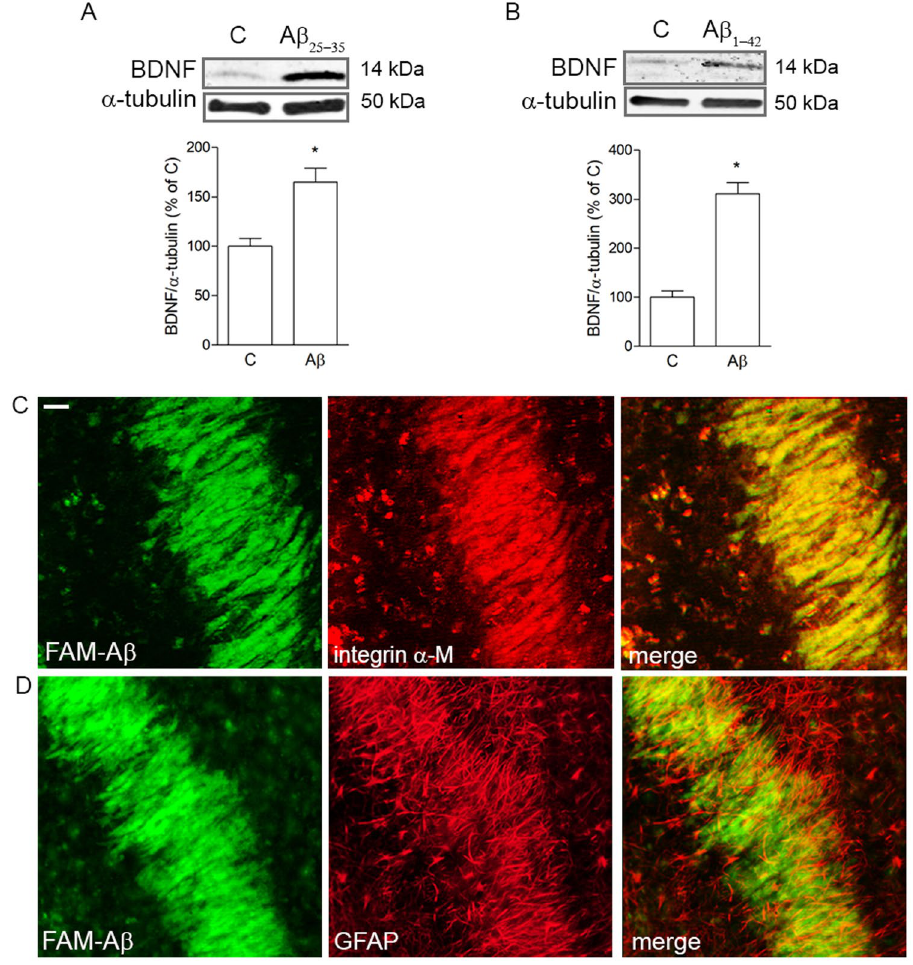
Figure 1. A β up-regulates mature BDNF expression and co-localizes with microglia in OHC. Western blot analysis of BDNF expression in OHC slices treated with 2 μ M A β 25-35 for 24 h ( A ) or 0.5 μ M A β 42 for 7 days ( B ). Co-localization of FAM-A β (green) in CA1 area of OHCs with cell type markers, integrin α -M (red, C ) and GFAP (red, D ), observed 24 h after its addition to the slices. Scale bar is 20 μ m. Values are mean ± SEM with n = 3. * p < 0.05 vs. control by Student’s